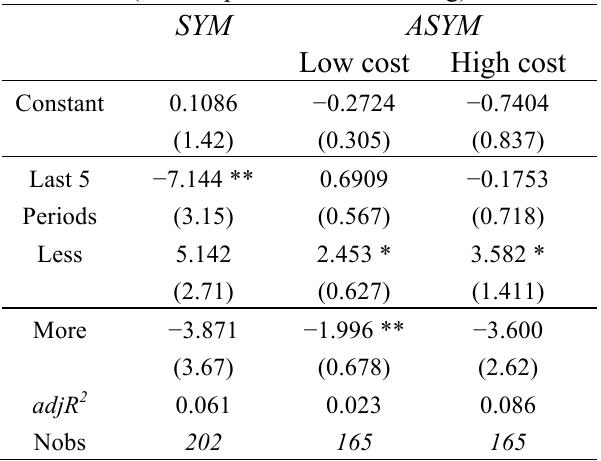
Table 3. Change in effort in the VOLUNTARY SYM and ASYM treatments. (Least squares with